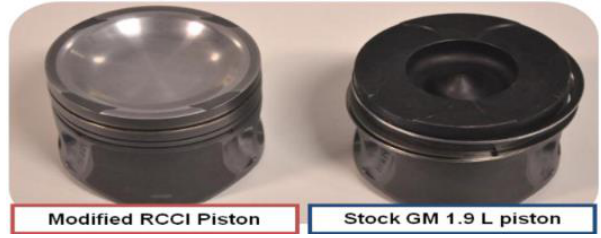
Fig. 14. Photo of modified RCCI piston and stock GM 1.9 L piston (repro- duced from [1]) Fig. 17. Comparison of piston bowl geometries (graphic based on [6])